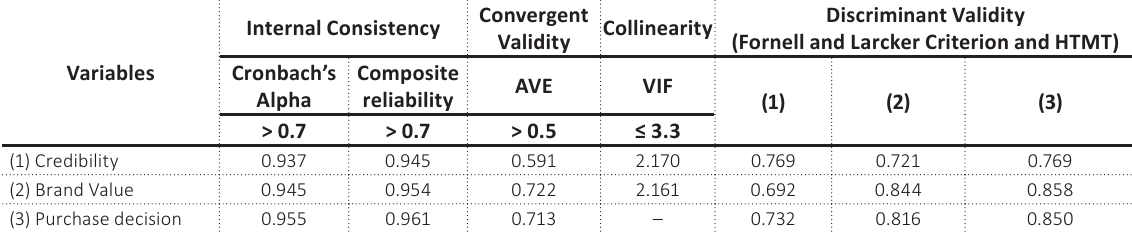
Source: Authors’ elaboration.